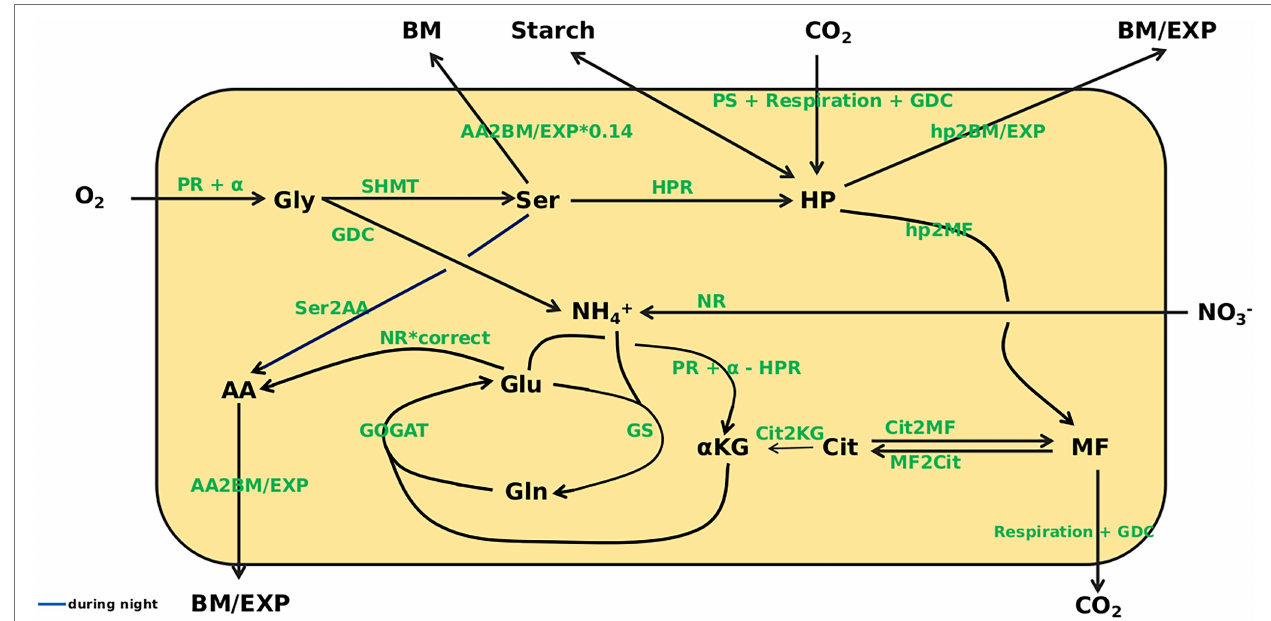
FIGURE 3 | Overview of the model. Model states are given in black. O 2 , CO 2 , biomass (BM), Starch, export (EXP), and NO 3 − are outside the system boundary. Gly, glycine; Ser, serine; HP, hexose-phosphates; MF, malate + fumarate; Cit, citrate; α -KG, α -ketoglutarate; Glu, glutamate; Gln, glutamine; AA, amino acids; NH 4+ , ammonium. For the following fluxes mass balance kinetics were used: hp2BM/EXP, hp2MF, Cit2MF, MF2Cit, Cit2KG, Ser2AA, AA2BM/EXP. The remaining reactions are represented as Michaelis–Menten